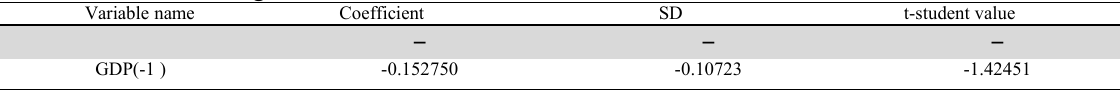
The results of estimating the VECM model